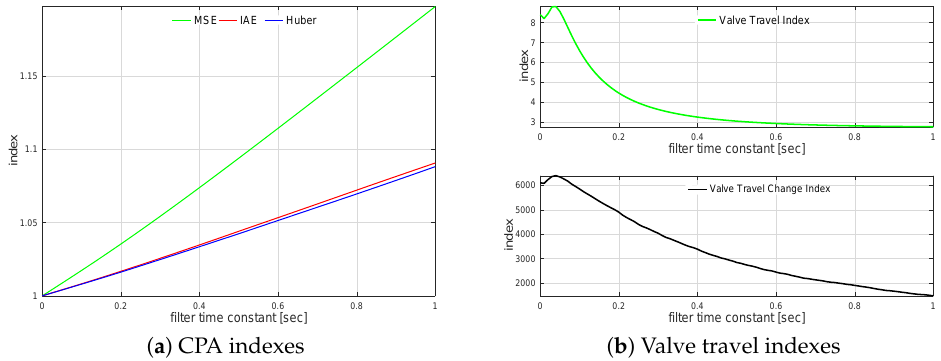
Figure 9. Control error filtering relationships for G 3 ( s ) .